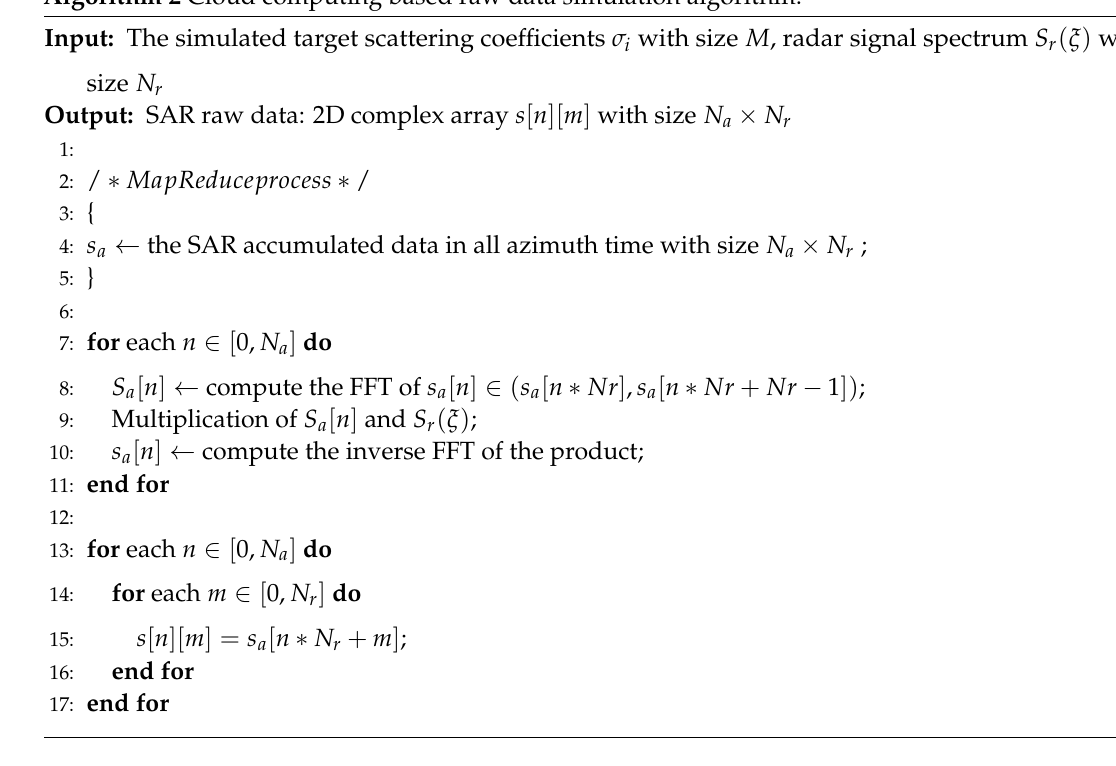
Algorithm 2 Cloud computing based raw data simulation